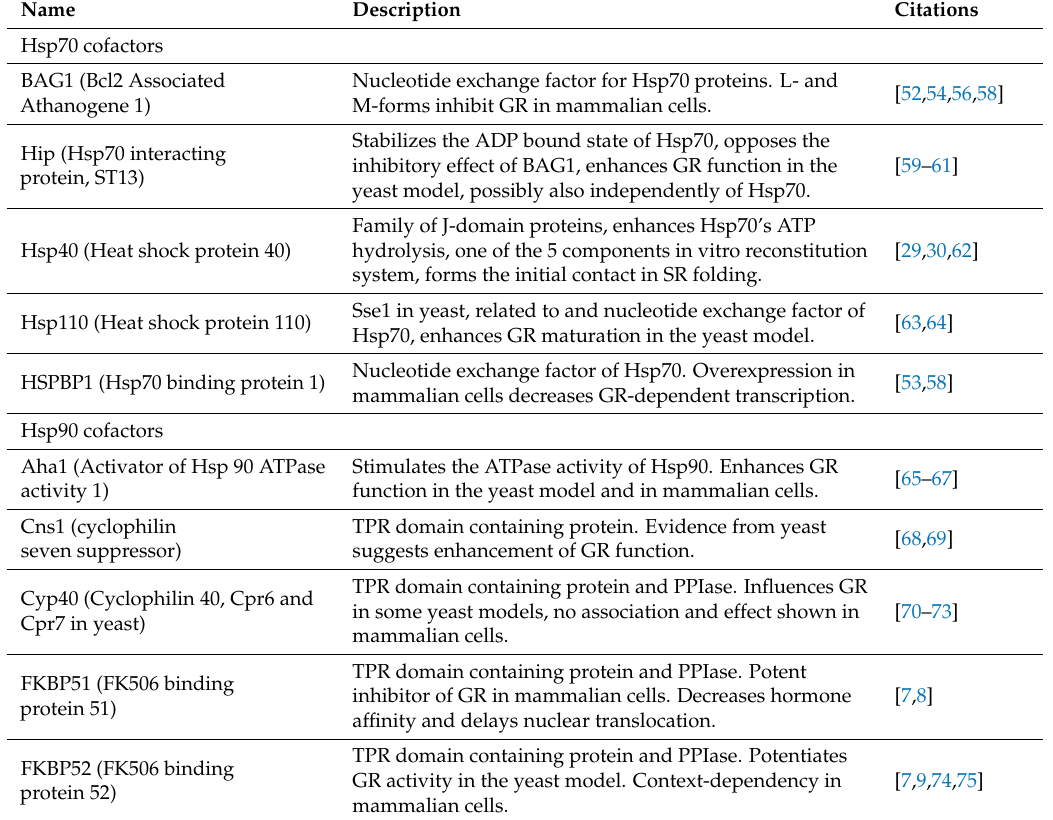
Table 1. Cofactors of Hsp90 and Hsp70 with demonstrated influence on GR activity. For more details, the reader is referred to the original citations provided. (Cofactors of Hsp90 and Hsp70 relevant for GR